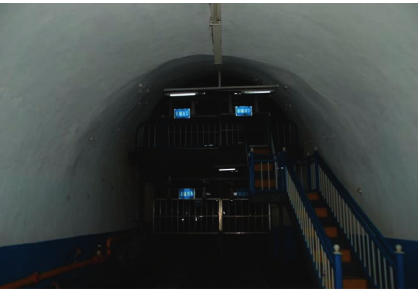
Figure 18: Application